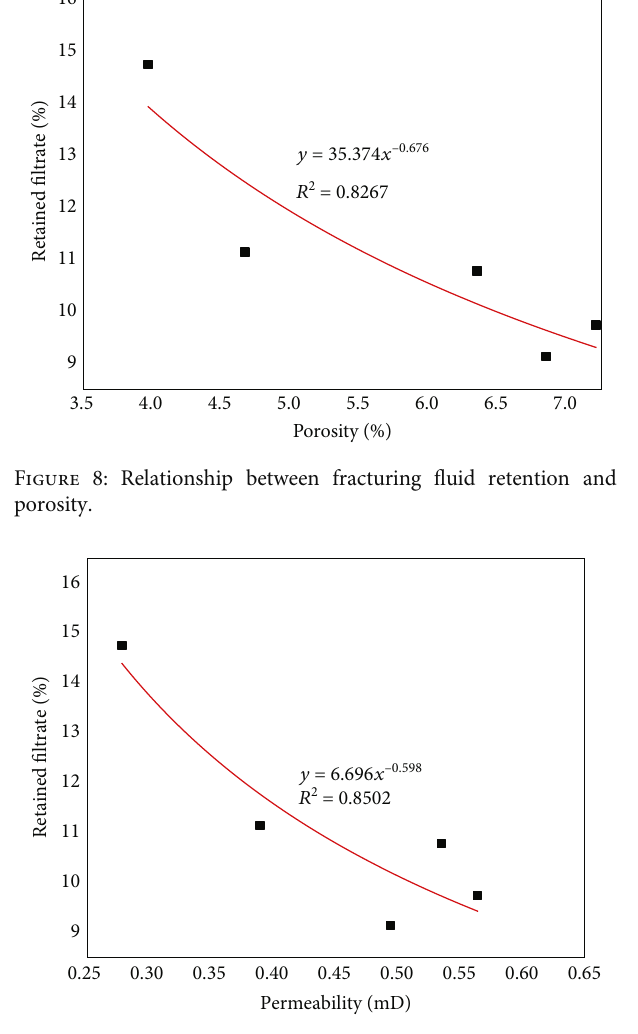
Figure 9: Relationship between fracturing fl uid retention and permeability.